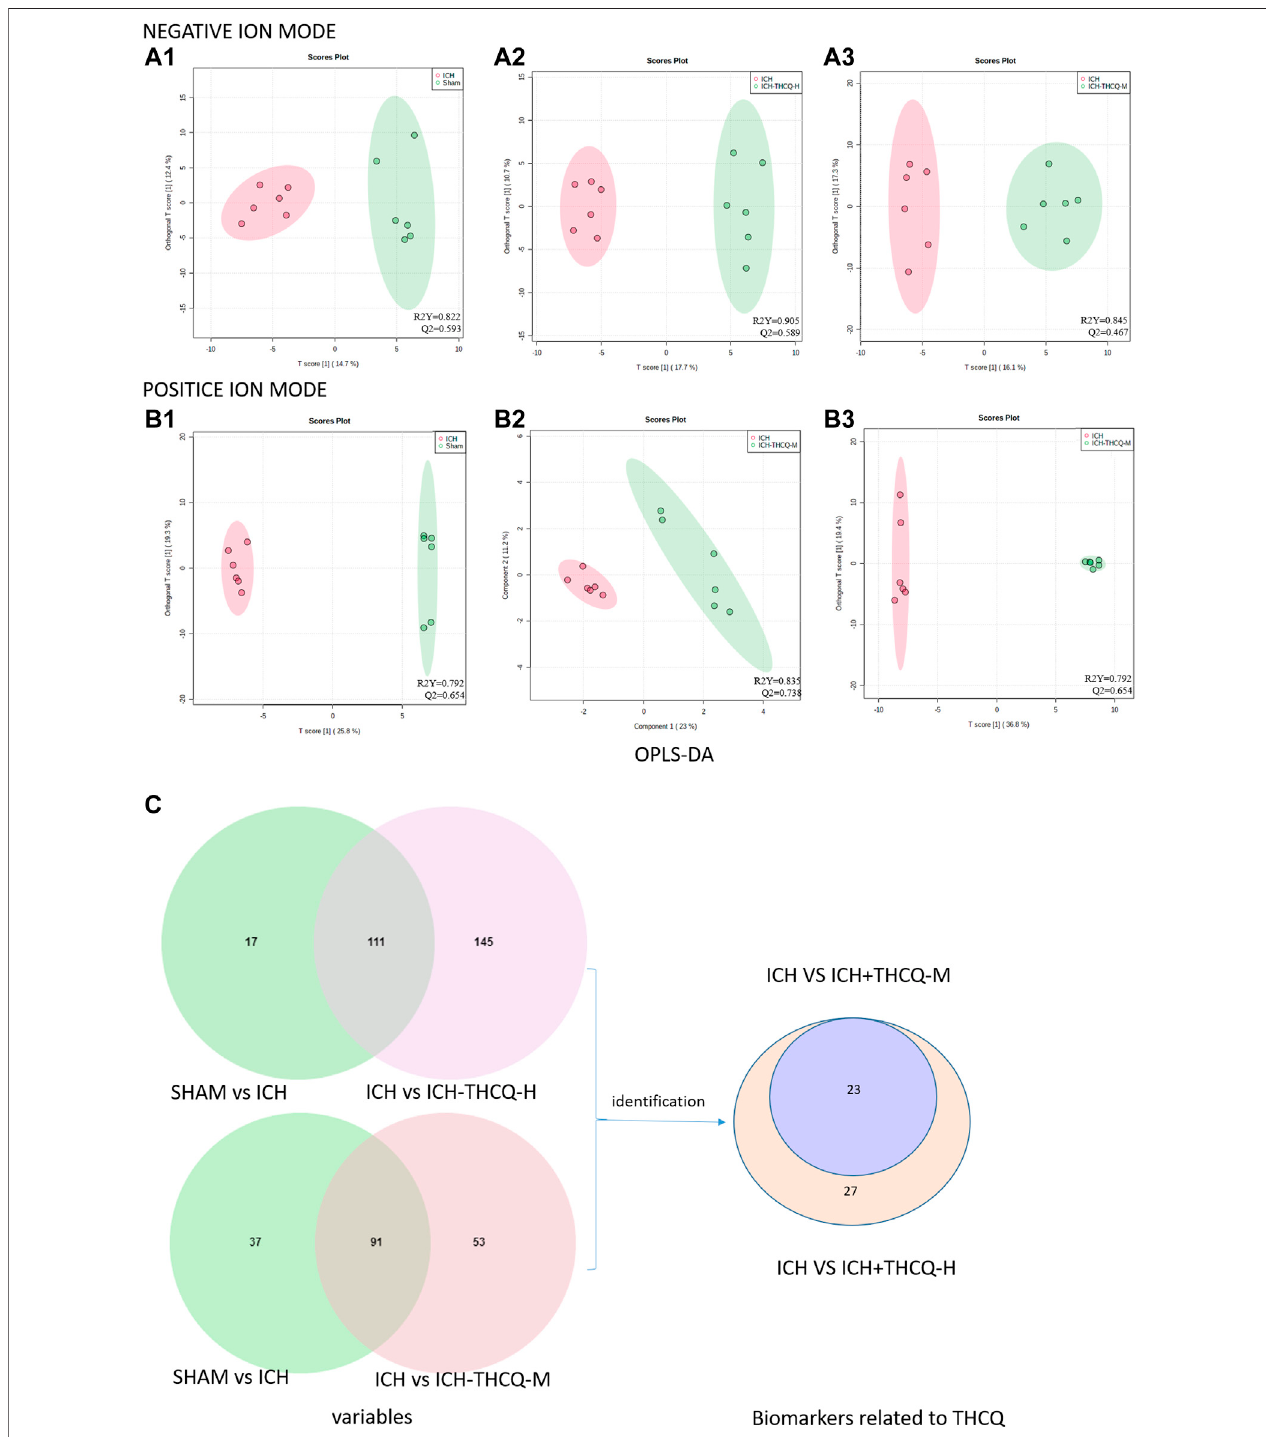
FIGURE6| Screeningofserum candidatebiomarkers.(A, B)OPLS-DAscoreplotsoftheshamvs. ICHgroups (A1, B1) ,ICH vs.ICH +THCQ -Hgroups (A2,B2) , and ICH vs. ICH +THCQ -M groups (A3, B3) in negative and positive ion modes, respectively (n (cid:2) 6 per group). (C) Venn diagram illustrated theoverlapping and unique differential metabolites among the comparison groups. Serum levels of 23 metabolites variations in the intermediate-dose and high-dose groups were prominently recovered, while 4 other metabolites level were only regulated at high doses of THCQ decoction.